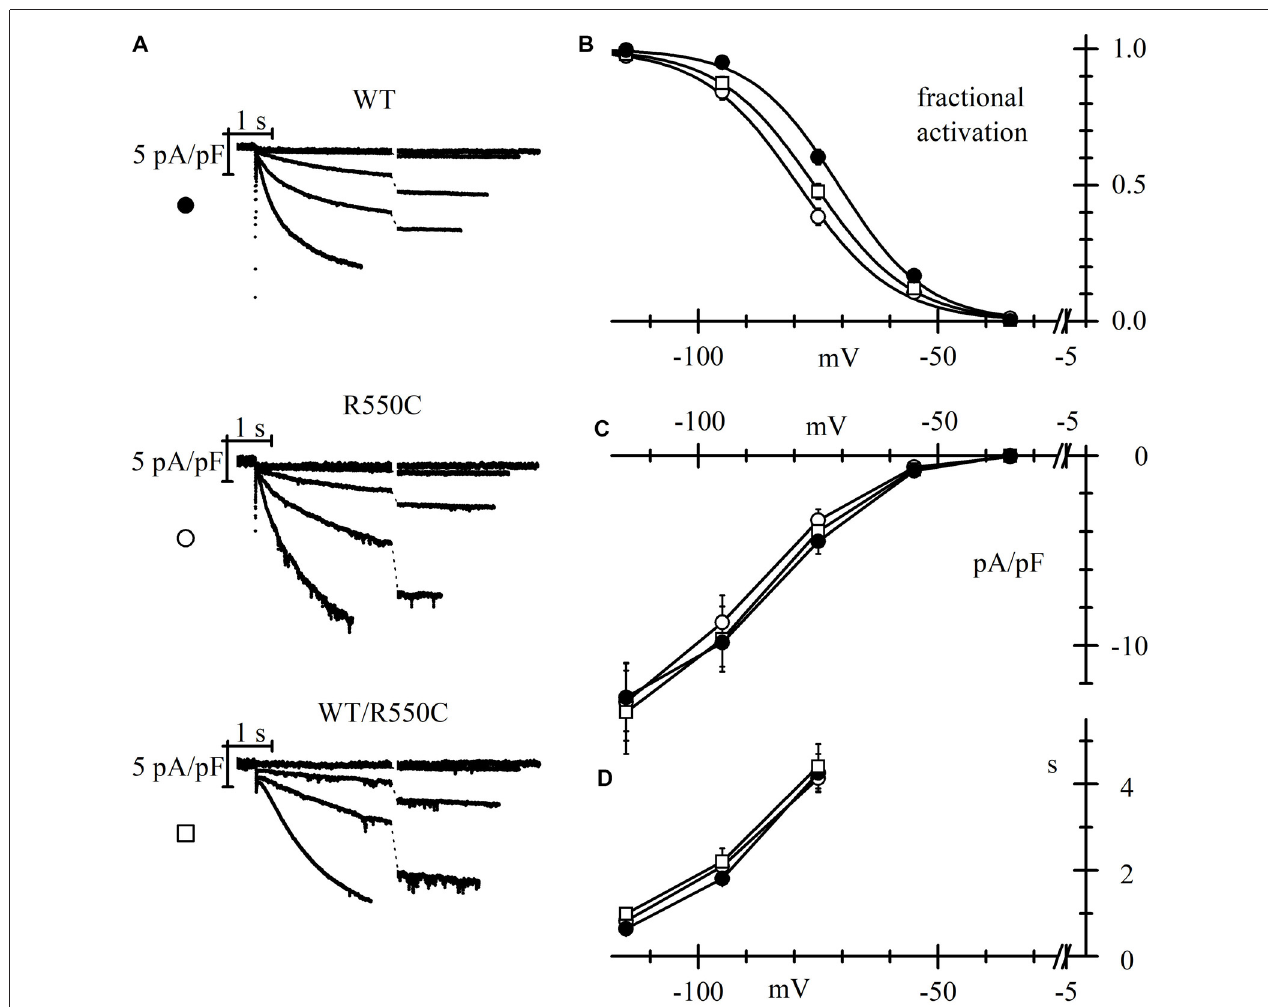
FIGURE 4 | The R550C mutation causes a shift of HCN4 activation curve when expressed in rat neonatal cortical neurons. (A) Representative hHCN4 current traces recorded during a single step protocol (test range − 35/ − 115 mV, hp = − 30 mV) in cortical neurons transfected with either WT, R550C or WT/R550C hHCN4, as indicated. Breaks in the current traces correspond to a 8.5 s duration. (B) Plot of the mean hHCN4 activation curves (meaning of symbols as in Figure 2 ). Mutant channels have activation curves shifted by about 5–8 mV in the negative direction relative to WT channels. V 1 / 2 and s values from Boltzmann fitting were (mV): WT, − 71.1 ± 1.1, 8.4 ± 0.3 ( n = 21); R550C, − 78.8 ± 1.1, 9.2 ± 0.5 ( n = 18); WT/R550C, − 75.8 ± 1.2, 9.8 ± 0.6 ( n = 12). (C) I/V density curves. Current densities at − 115 mV were (pA/pF): WT, − 12.3 ± 1.5 ( n = 20); R550C, − 12.7 ± 1.8 ( n = 19); WT/R550C, − 13.1 ± 2.2 ( n = 19). (D) Mean time constants of activation. In (C,D) no significant differences were found among the three channel types.